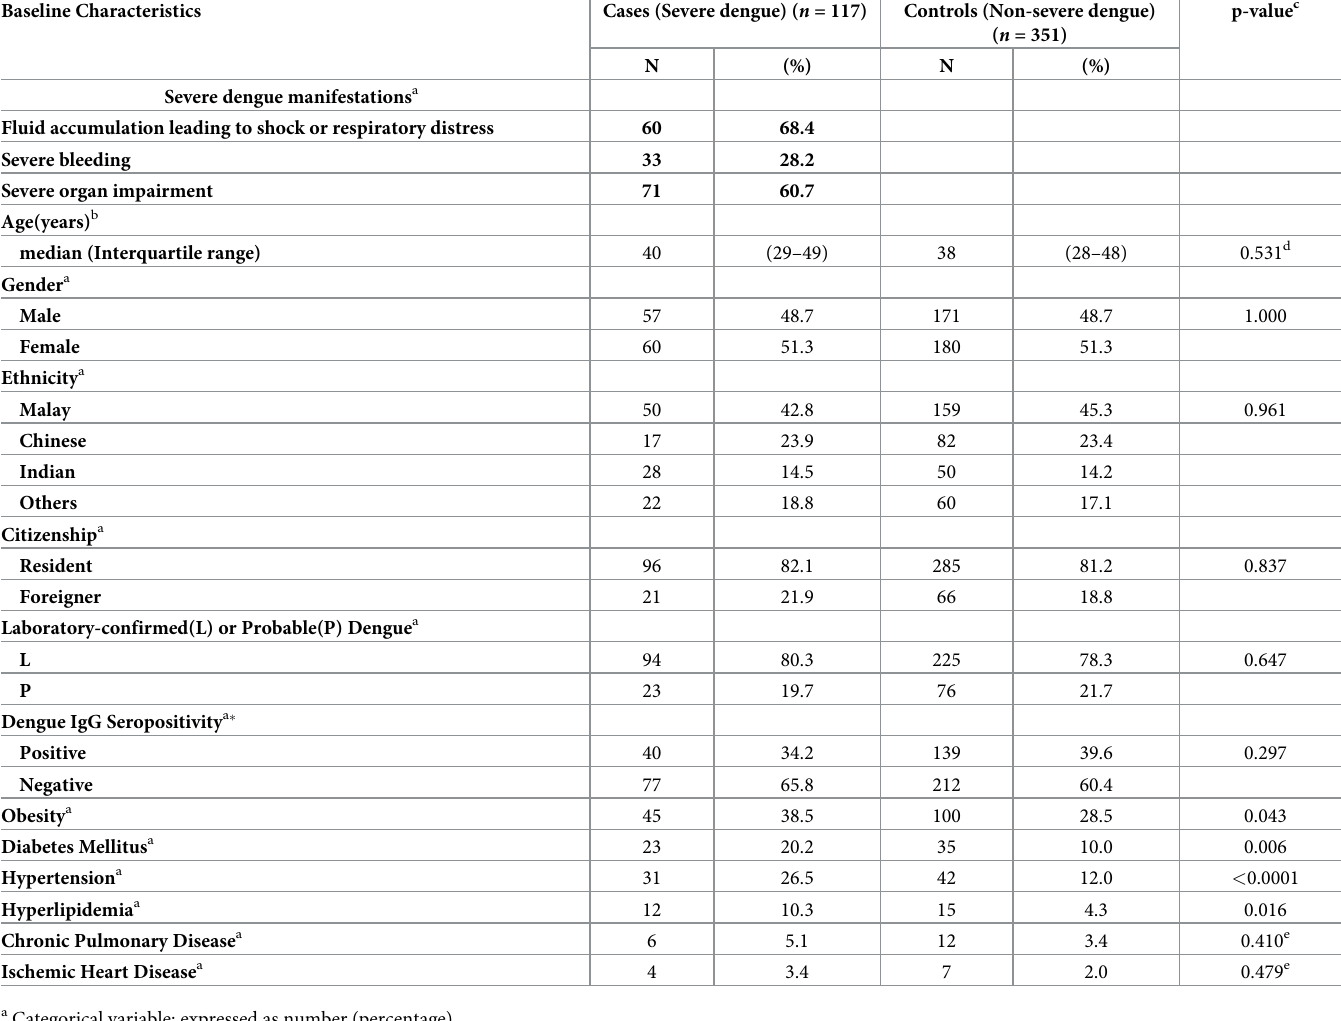
Table 1. Baseline Characteristics of cases (severe dengue) and controls (non-severe